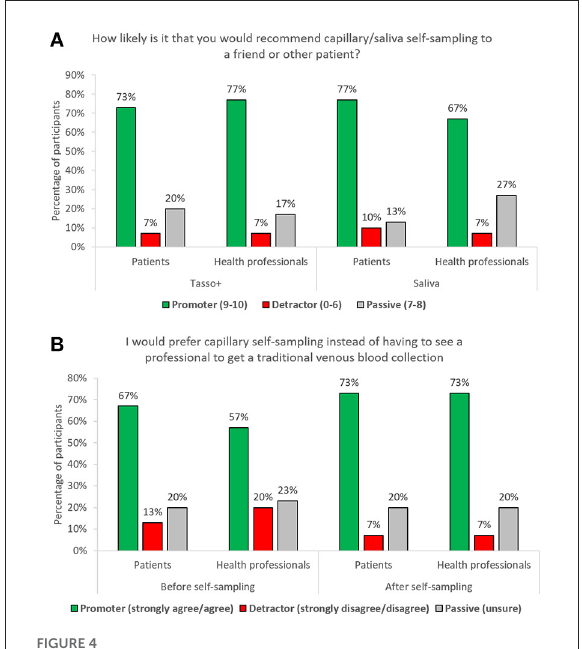
FIGURE4 (A) Percentage of participants per group according to respective net promoter category and self-sampling device; (B) participants preference of capillary self-sampling over traditional venous blood collection.